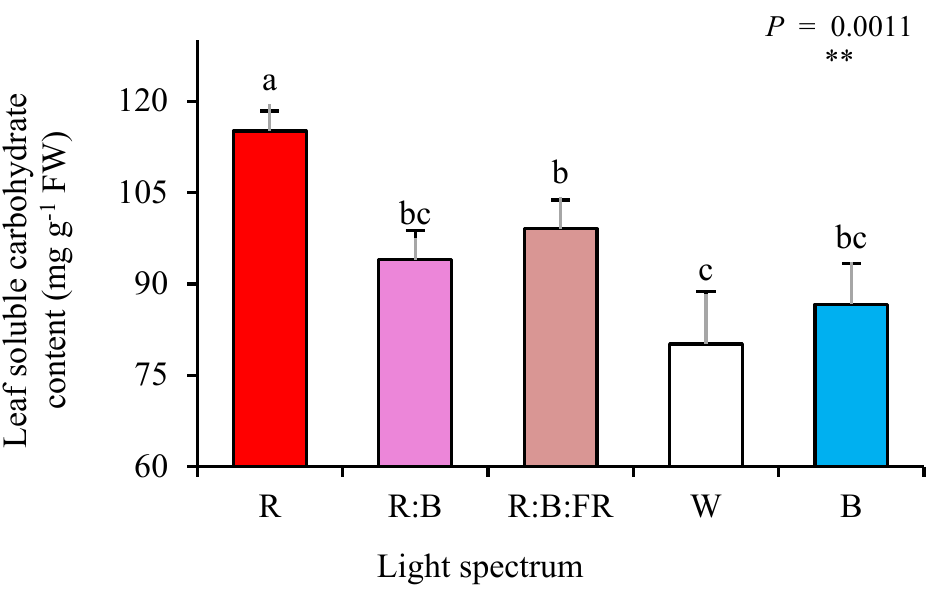
Figure 2. Leaf soluble carbohydrate content of chrysanthemum cuttings exposed for 30 days to different light quality regimes (red (R), red and blue (R:B), red, blue and far-red (R:B:FR), white (W) and blue (B); see the spectrum in Figure 9). During the experiment, the photosynthetic photon flux density was set to 150 ± 5 µ mol m − 2 s − 1 . Six replicates per treatment were assessed. Columns with the same letters are not significantly different at p ≤ 0.05, according to Duncan’s multiple range tests. Bars represent SEM.